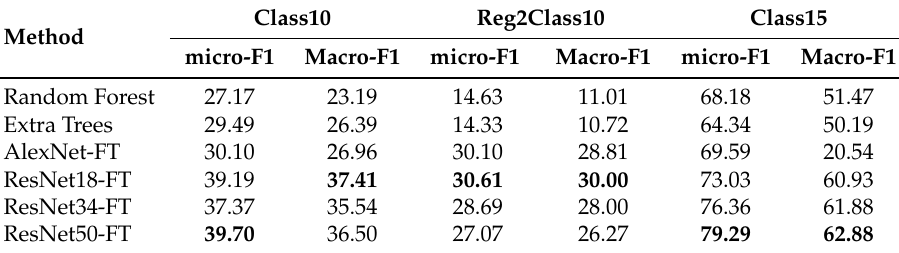
Table 6. Results for each tested method for the different training settings.